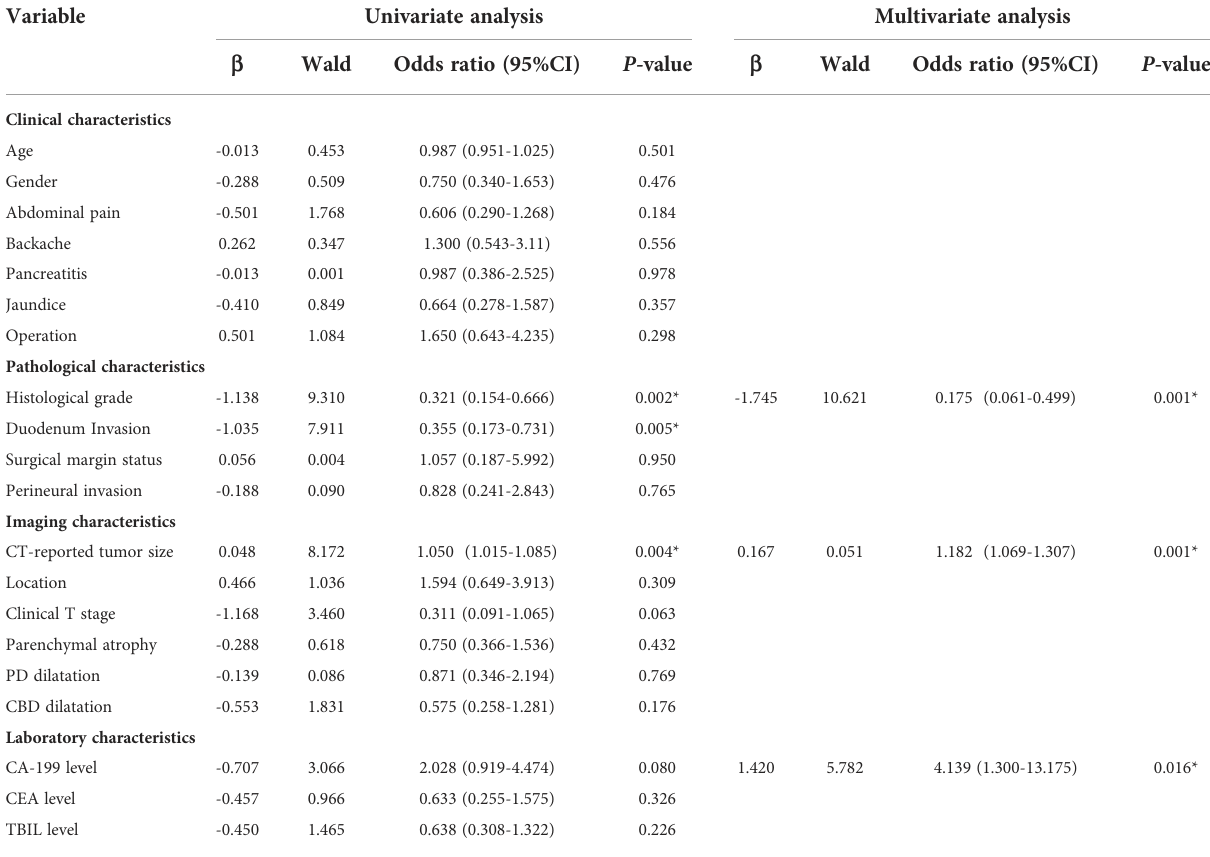
TABLE 2 Univariate and multivariable logistic regression analyses in selecting